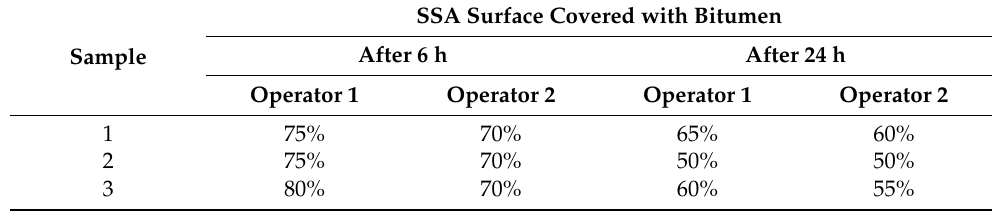
Table 3. Determination of affinity between SSA and bitumen.